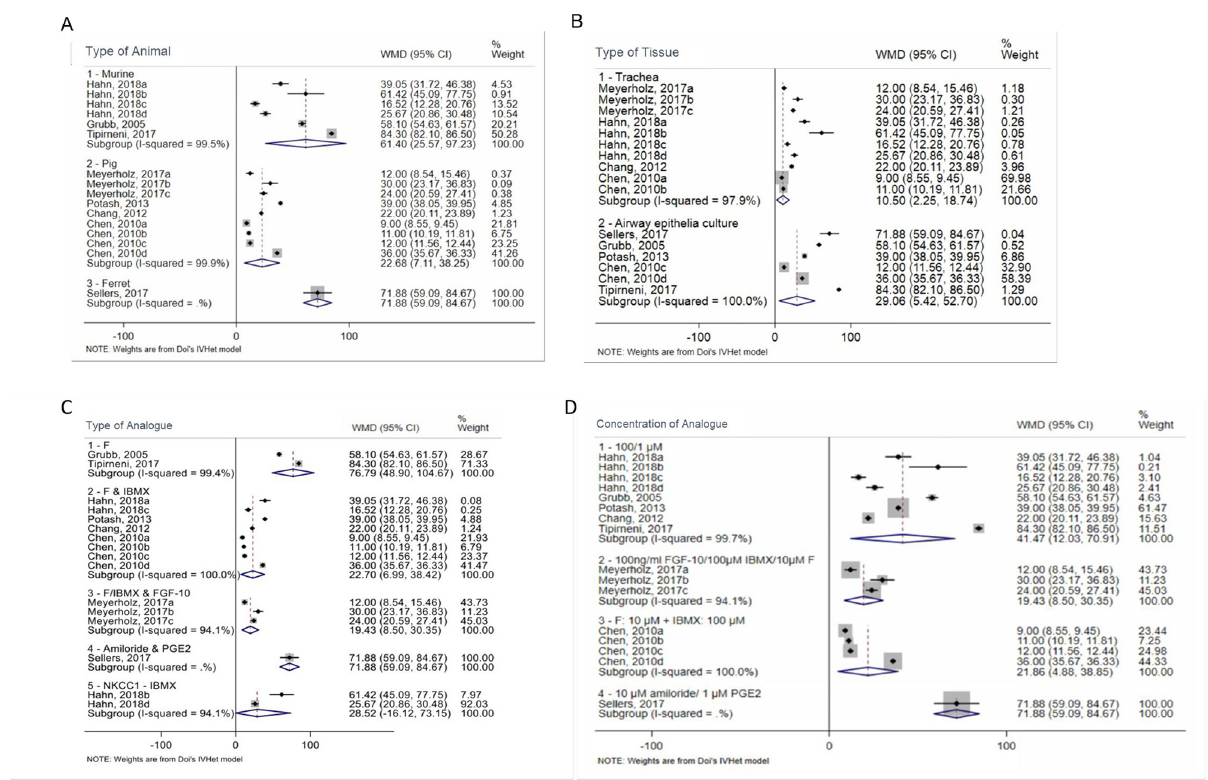
Fig 4. Subgroup analysis based on Animal Type (A), Tissue Type (B), Analogue type used (C) and Concentration of analogue used (D). F: Forskolin, IBMX: 3-isobutyl-1-methylxanthine, FGF-10: Fibroblast Growth Factor 10, PGE2: Prostaglandin E2, NKCC1: Na-K-Cl cotransporter protein. References: Sellers [27]; Meyerholz [26]; Hahn [25]; Grubb [31]; Potash [33]; Chang [34]; Chen [35]; Tipirneni [32]; Suzuki [28]; Hawkins [30]; Crane